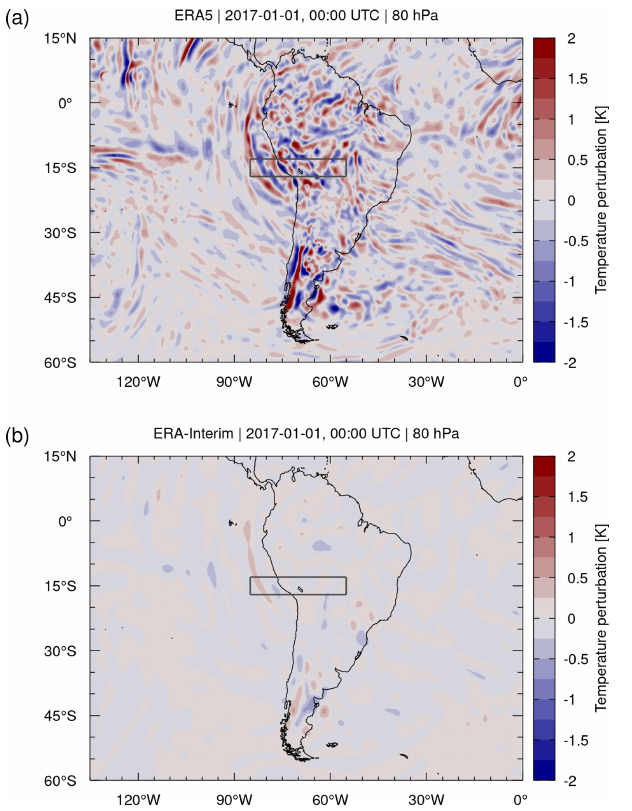
Figure 10. Temperature perturbations (contour surface) derived by means of a horizontal Gaussian high-pass filter applied to (a) ERA5 and (b) ERA-Interim reanalysis data on 1 January 2017, 00:00UTC. Light gray curves are ERA5 and ERA-Interim temper- ature contours at levels of 2K, respectively. Also shown are the geopotential heights of the WMO first tropopause (red curve) and the cold point (black